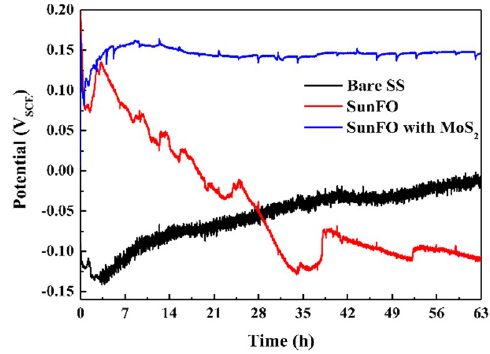
Figure 8. Open-circuit potential of specimens during the immersion time.